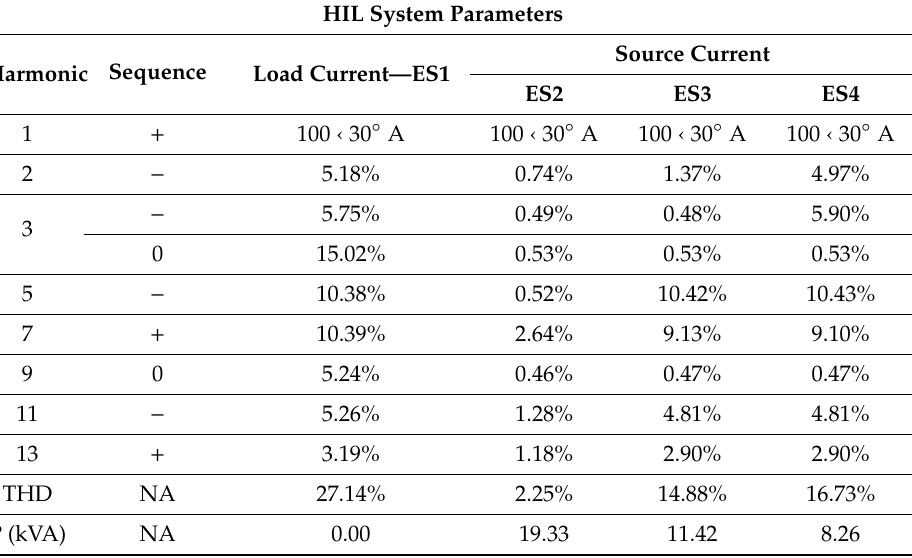
Figure 13. ES4 scenario. ( a ) 3-phase and neutral source current. ( b ) Output Filter Current. ( c ) Source, load and output filter phase-a current. ( d ) source, load and output filter neutral current. Current scale is configured to 50 A/div and time scale is configured to 2.50 ms. Table 7. Harmonic Components Results.